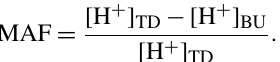
Figure 9. Fraction of cloud water samples where [NH + [NO − ] (left axis) and annual median missing acid fraction (right 3